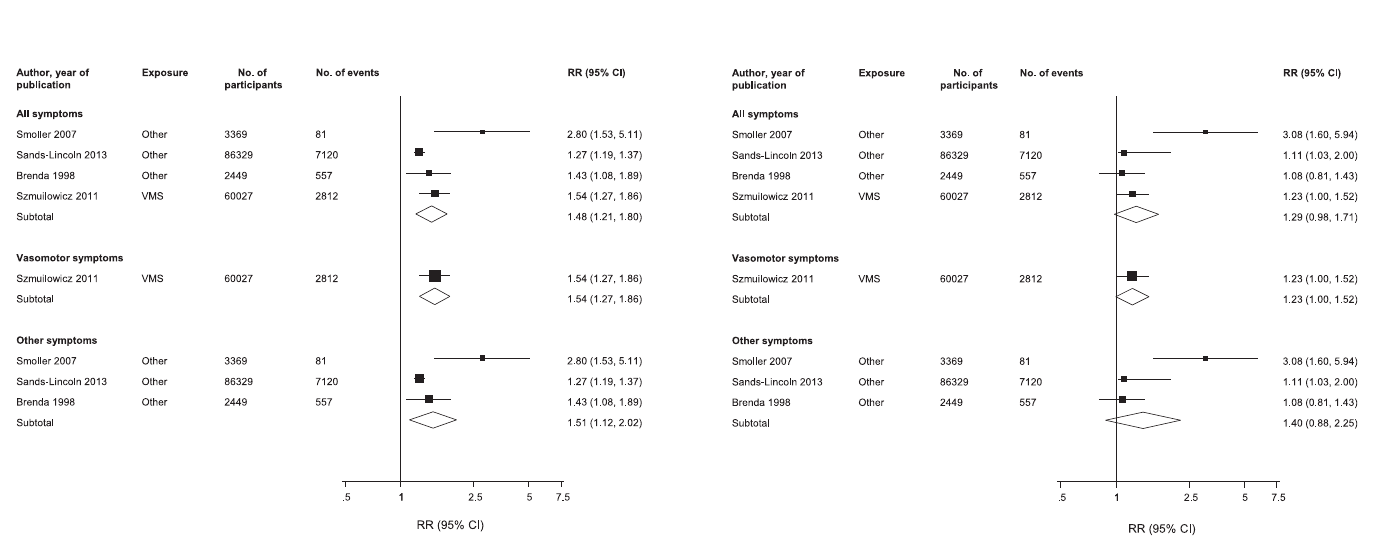
Fig 4. Relative risks of cardiovascular disease associated with menopausal symptoms. Basic model: adjusted for age and non-established cardiovascular risk factors; Fully-adjusted model, adjusted for established cardiovascular risk factors and potential mediators. VMS, vasomotor symptoms; vasomotor symptoms include hot flashes and /or night sweats; All, includes vasomotor and other menopausal symptoms; Other, includes menopausal symptoms such as depression, insomnia, and panic attacks. Assessment of heterogeneity for basic model: All symptoms, X2 3 = 9.95, I2 = 70%, 13 to 90%; P = 0.019; other symptoms, X2 2 = 7.05, I2 = 72%, 4 to 92%; P = 0.045. Assessment of heterogeneity for full-adjusted model: All symptoms, X2 3 = 8.68, I2 = 65%, 0 to 88%; P = 0.034; other symptoms, X2 2 = 8.67, I2 = 77%, 25 to 93%; P = 0.013.